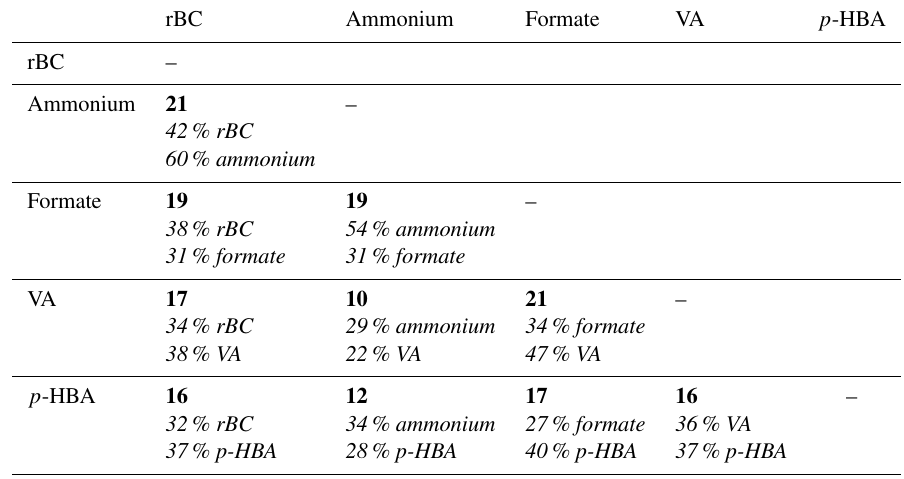
Table 3. Number of peaks matching within ± 1 year among the different fire proxies (in bold) for the time period 1222–1800. Italic numbers below give the percentage of matching peaks in relation to the total number of peaks for each proxy. rBC Ammonium Formate VA p